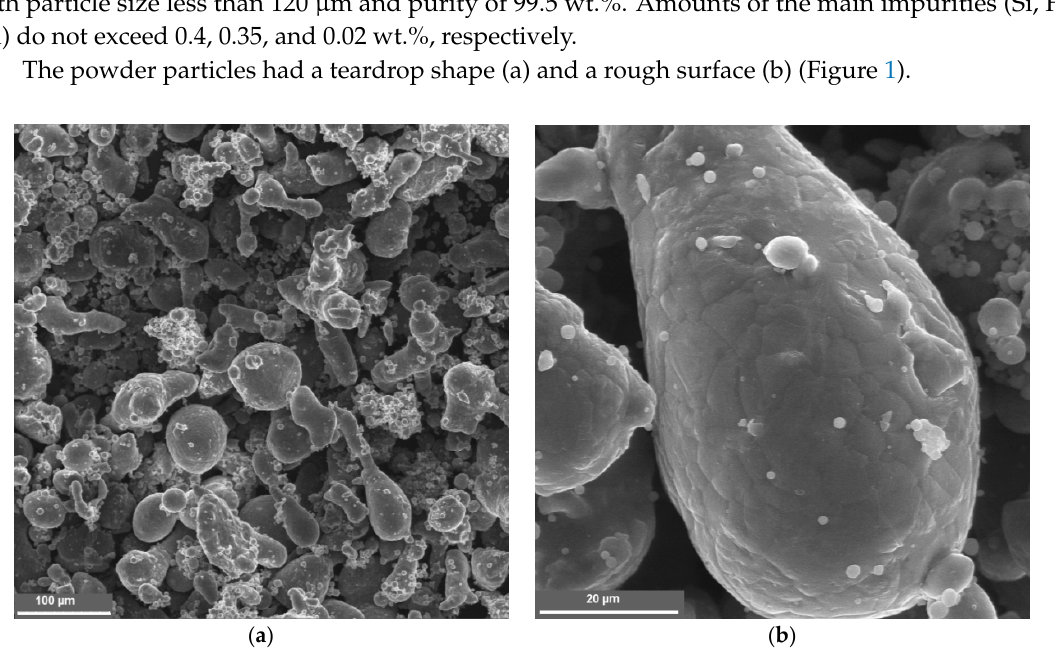
Figure 1. Microstructure of the composite particle: ( a ) a teardrop shape and ( b ) a rough surface.